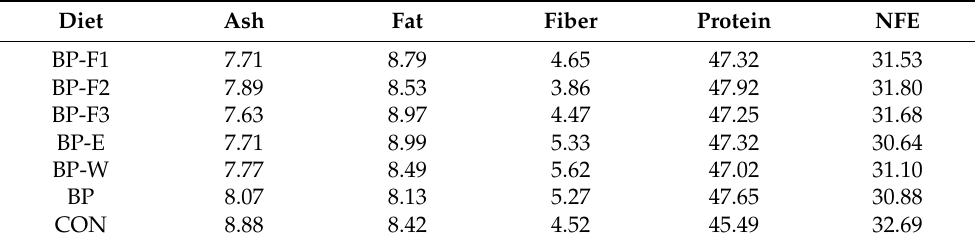
Table 2. Proximate composition of diets used in growth study. All values are shown as g/(100 g dry